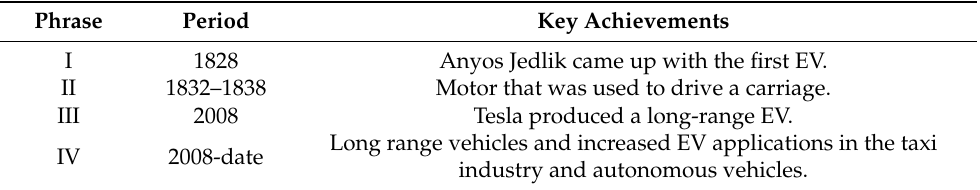
Table 1 summarizes the key achievements of EV in different phrases. Table 1. Key Achievements of EV in Different